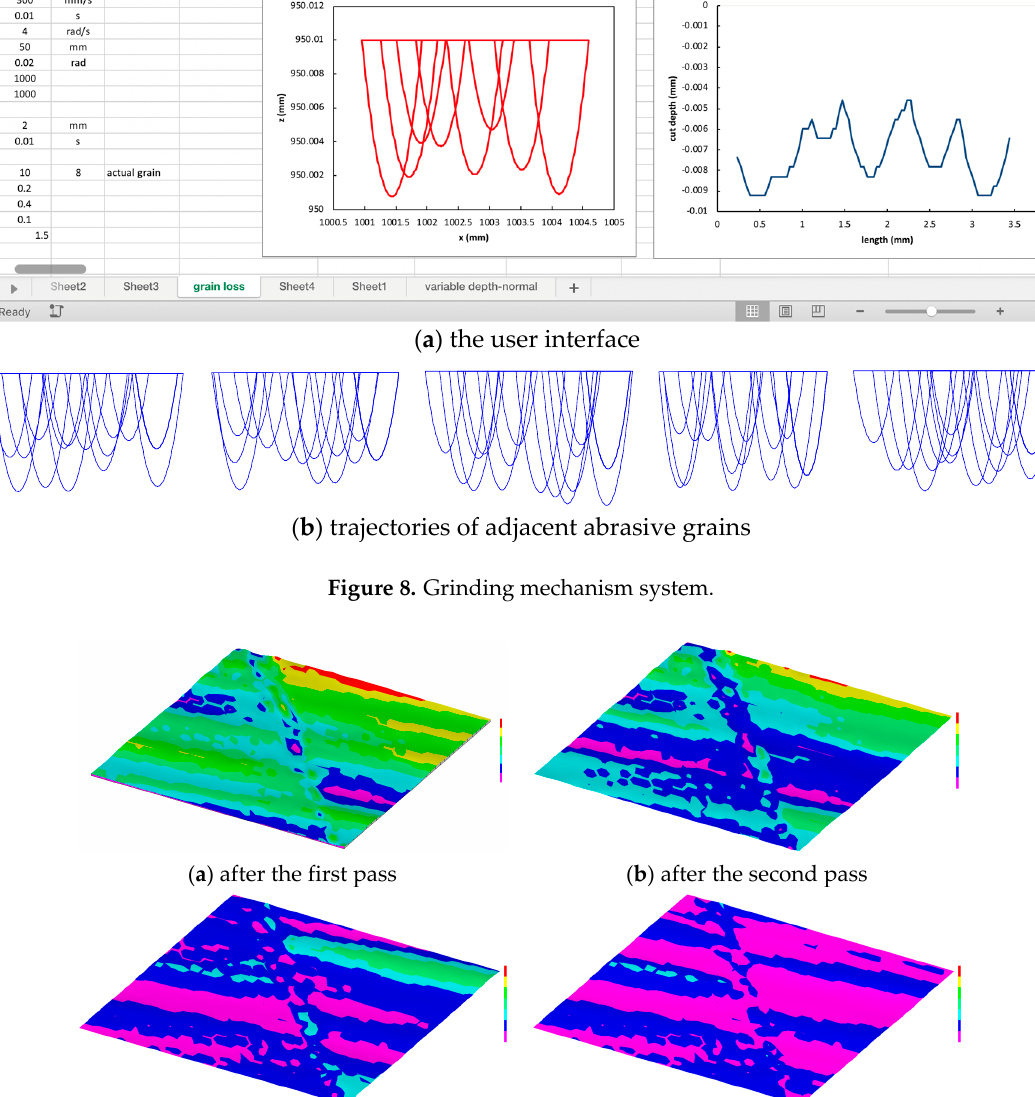
Figure 9. Theoretical surface topography of workpiece due to grinding.